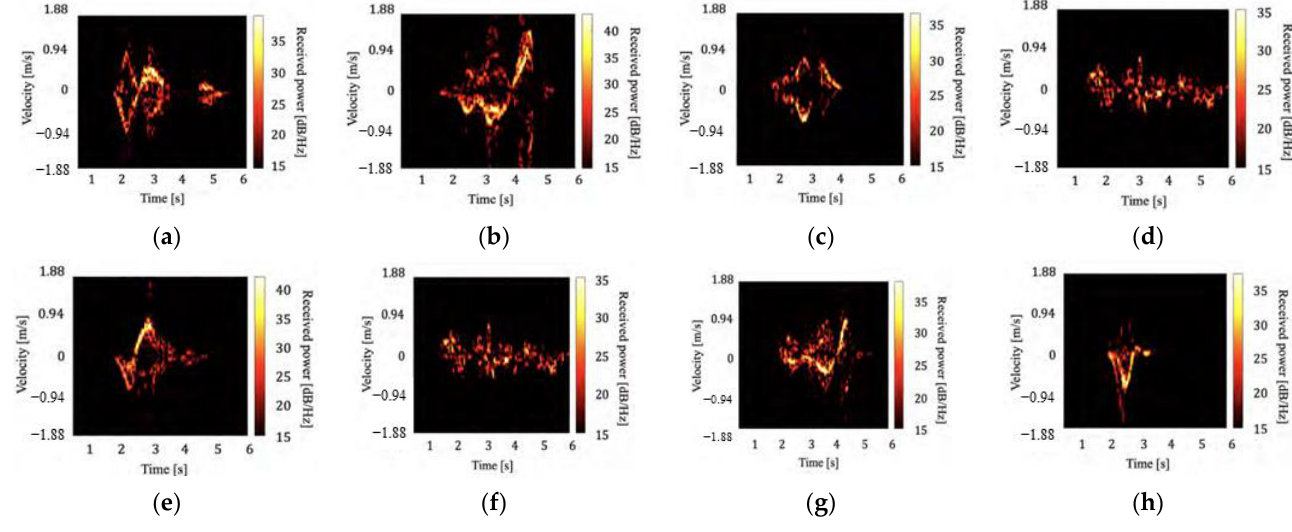
Figure 2. Examples of spectrograms measured with the ceiling radar. ( a ) Opening the toilet lid, ( b ) pulling down the pants, ( c ) sitting, ( d ) taking the toilet paper, ( e ) standing, ( f ) pulling up the pants, ( g ) closing the toilet lid, and ( h ) falling.